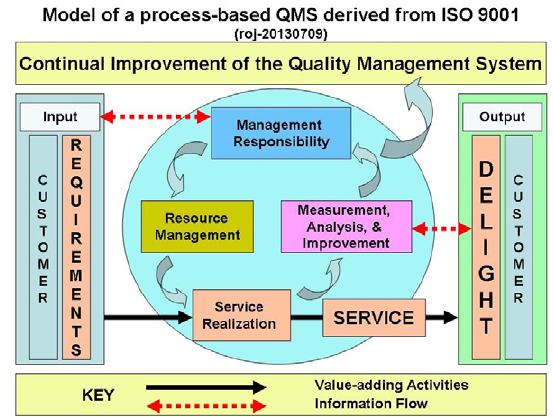
Figure 1. The scheme of relations between management principles and ISO 9000 focus (source: Ceko, 2017)